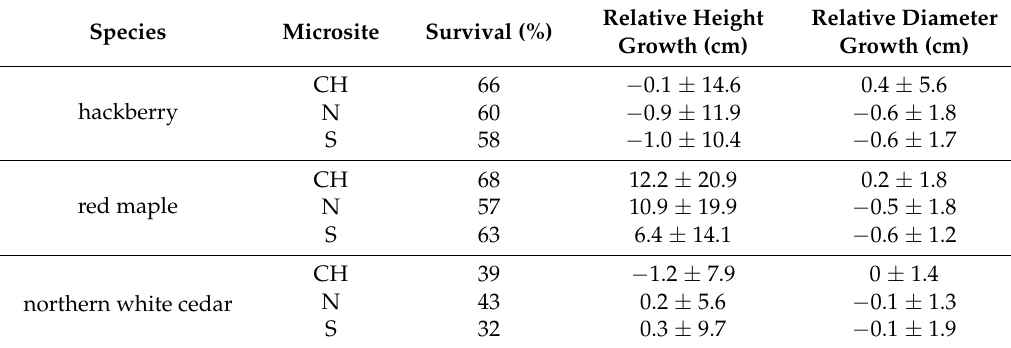
Table 5. Two-year mean seedling survival rate, height, and diameter across all treatments by microsite constructed hummock (CH), natural (N), and scarification (S) for each planted species in the Superior Municipal Forest study. There were no significant differences in seedling survival, relative height growth, and relative diameter growth. Species